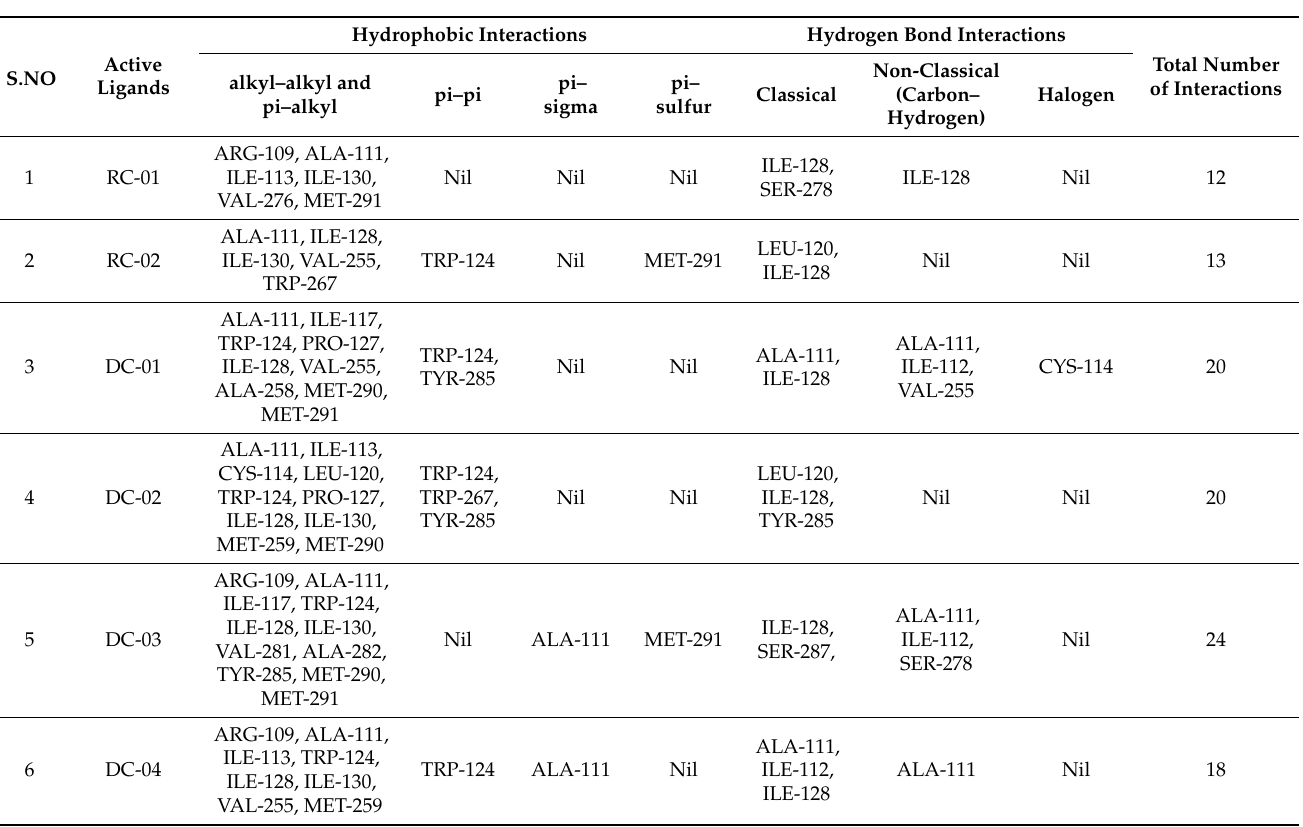
Table 3. The ligand–receptor interactions of designed and reference compounds after the MD simulation at the final